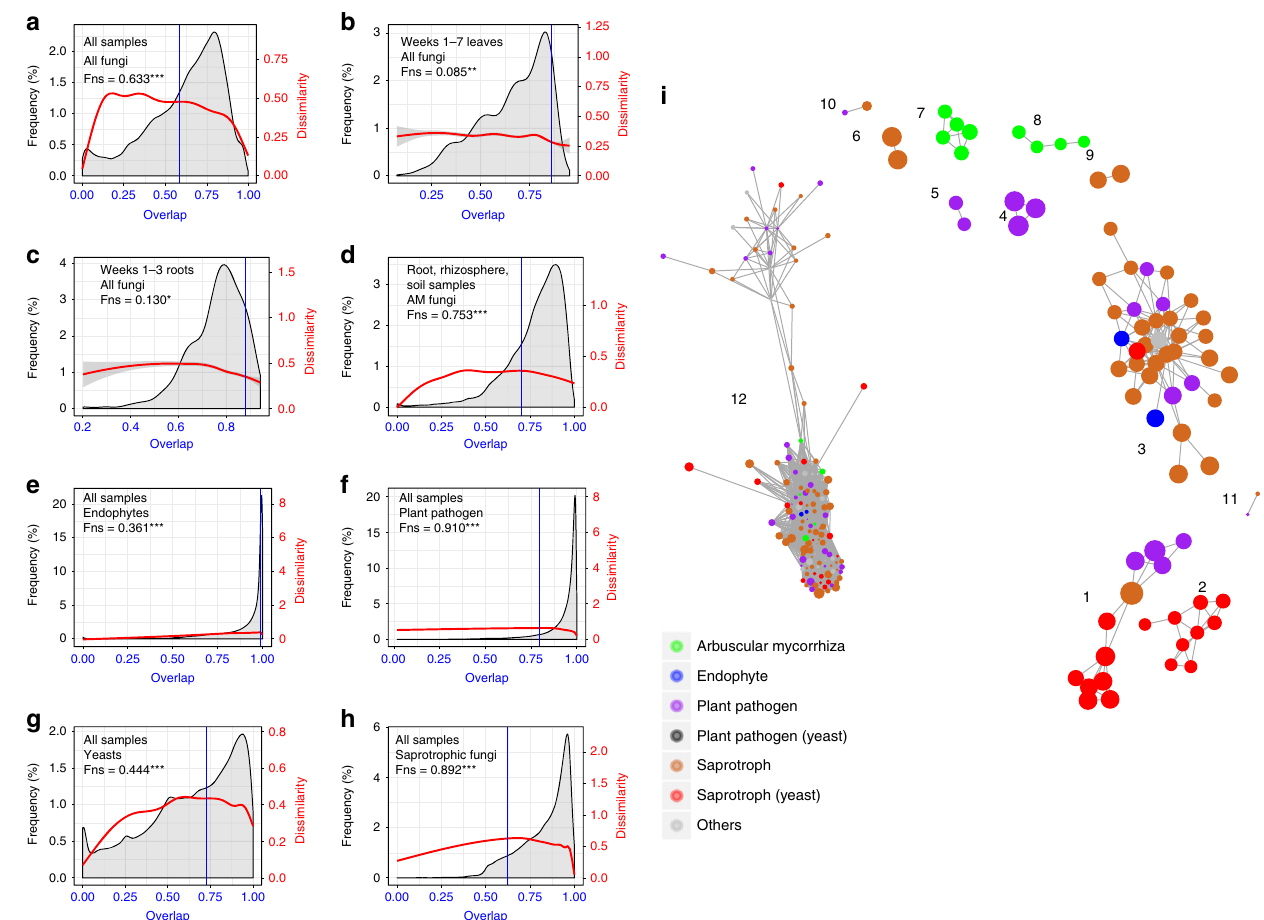
Fig. 6 Universality of ecological dynamics of the sorghum mycobiome. a – h Dissimilarity-overlap curves (DOC) for a all samples of all fungi, b leaf samples of weeks 1 – 7 for all fungi, c root samples of weeks 1 – 3 for all fungi, d root, rhizosphere and soil samples for all weeks of arbuscular mycorrhizal (AM) fungi, e all samples of endophytic fungi, f all samples of plant pathogenic fungi, g all samples of yeasts, and h all samples of saprotrophic fungi. For DOCs, the dissimilarity-overlap curve is in red, the distribution density of sample pair overlap is in gray, and the point at which a negative DOC is fi rst observed is marked by a vertical blue line (chosen by median of 1000 bootstraps). The fraction of negative slope (Fns) is simply the fraction of data points in the interval where the DOC has a negative slope and signi fi cance is as follows: * P < 0.05, ** P < 0.01, *** P < 0.001. i Co-occurring network of fungal guilds of sorghum Mycobiome. Each dot represents a fungal OTU, and each edge represents a positive correlation with R > 0.8 ( P ≪ 0.001). The different color represented the functional guilds of fungi. The dot size corresponds to OTU abundance (log transformed). Note for the 12th cluster, co-occurrence may be exaggerated among the large number of rare OTUs due to the dominance of zeros for rare OTUs in most samples. Source data are provided as a Source Data fi